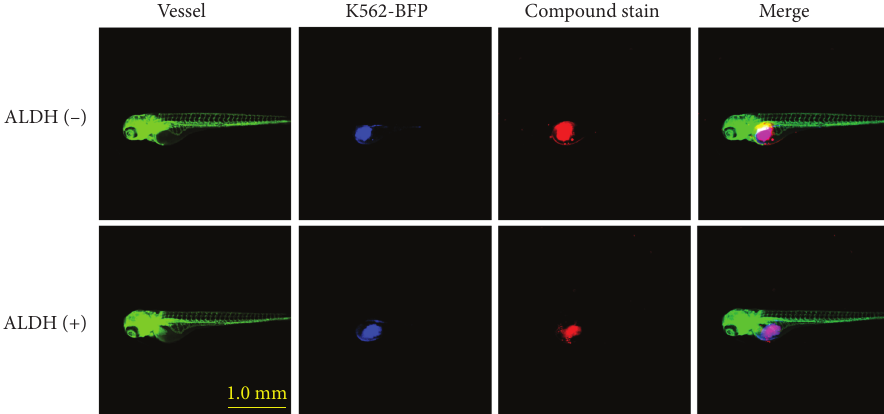
Figure 5: Selective staining on cancer cells in vivo . Representative images of the ALDH( − ) and ALDH(+) K562-BFP zebrafish xenograft (1 dpi; dpi, day postinjection) after 10 μ M compound intratumor injection for 1 h.